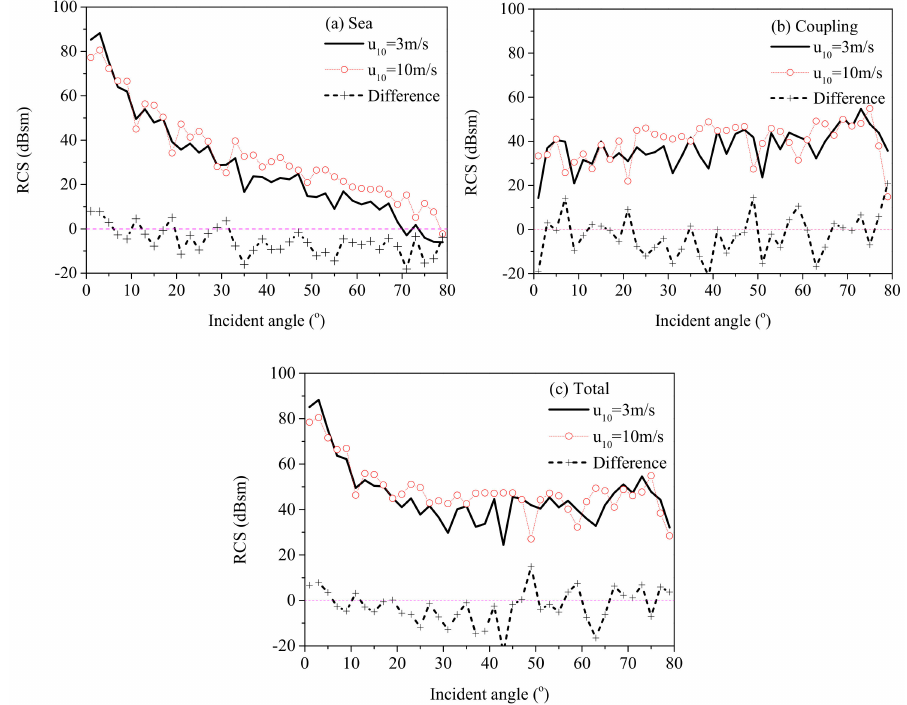
Figure 12. Comparison of RCS results in the yoz plane under di ff erent wind speeds. d = 25 m, w = 30 m. ( a ) RCS of the sea surface. ( b ) RCS from the coupling field. ( c ) RCS from the total